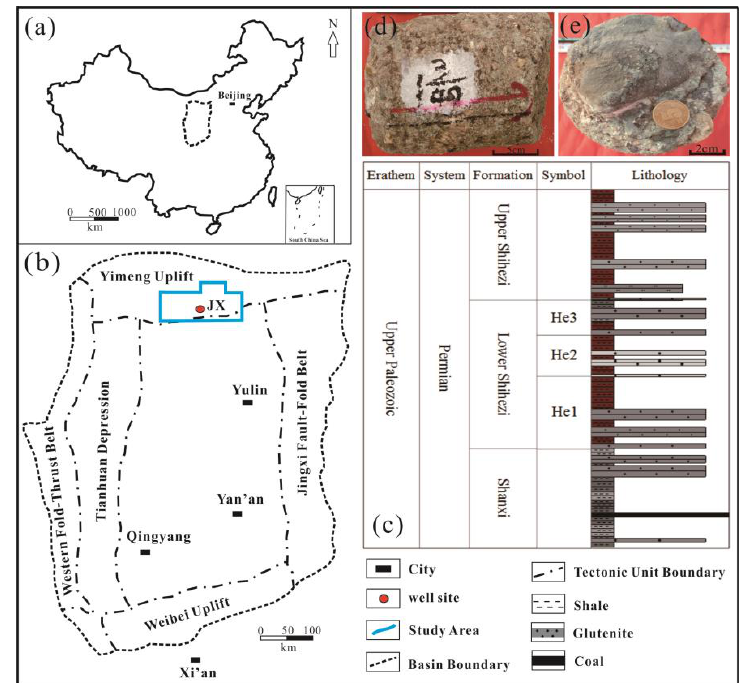
Figure1. ( a )ScopeofOrdosBasininChina; ( b )locationofHangjinqiareainOrdosBasin; ( c )stratigraphic sequence; ( d ) glutenite in the He3 member of the JX well, depth 3047.65–3047.77 m; ( e ) glutenite in the He3 member of the JX well, depth 3053.42–3053.68